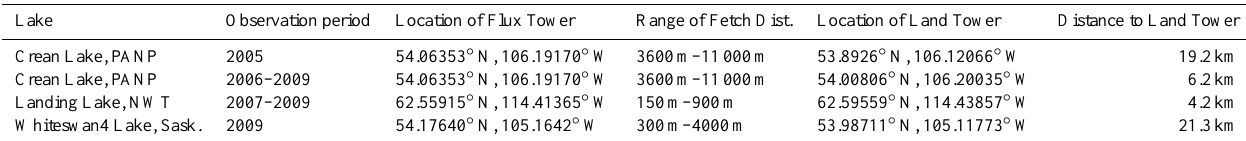
Table 1. Characteristics of three study lakes.